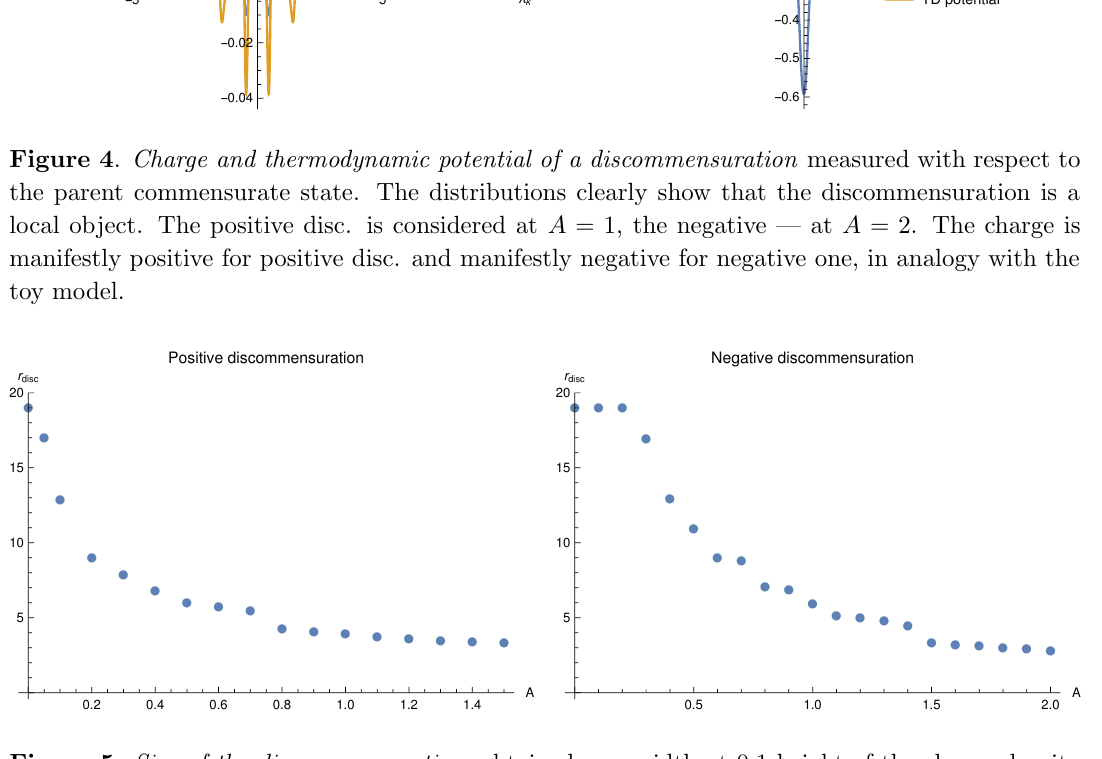
Figure 5 . Size of the discommensuration , obtained as a width at 0.1 height of the charge density (see (cid:12)gure 4), depending on the amplitude of the lattice. As the lattice becomes stronger, the discommensuration localizes, in complete analogy with the toy